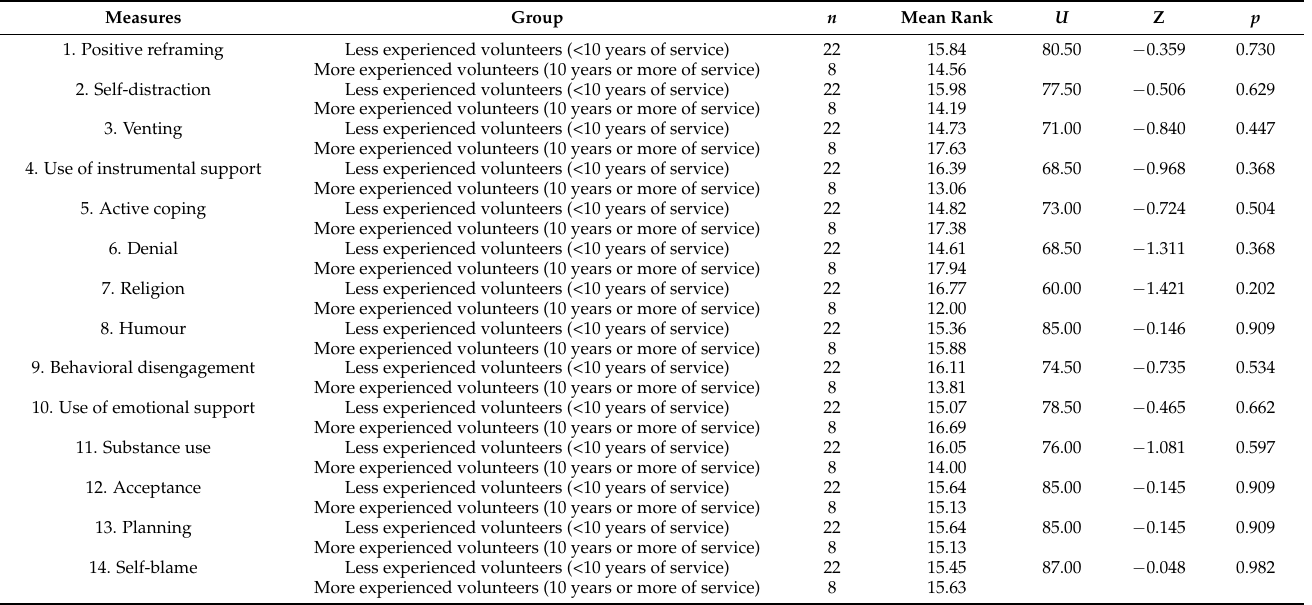
Table 7. Coping scale data of Civil Protection less experienced volunteers serving during the COVID-19 pandemic compared to more experienced